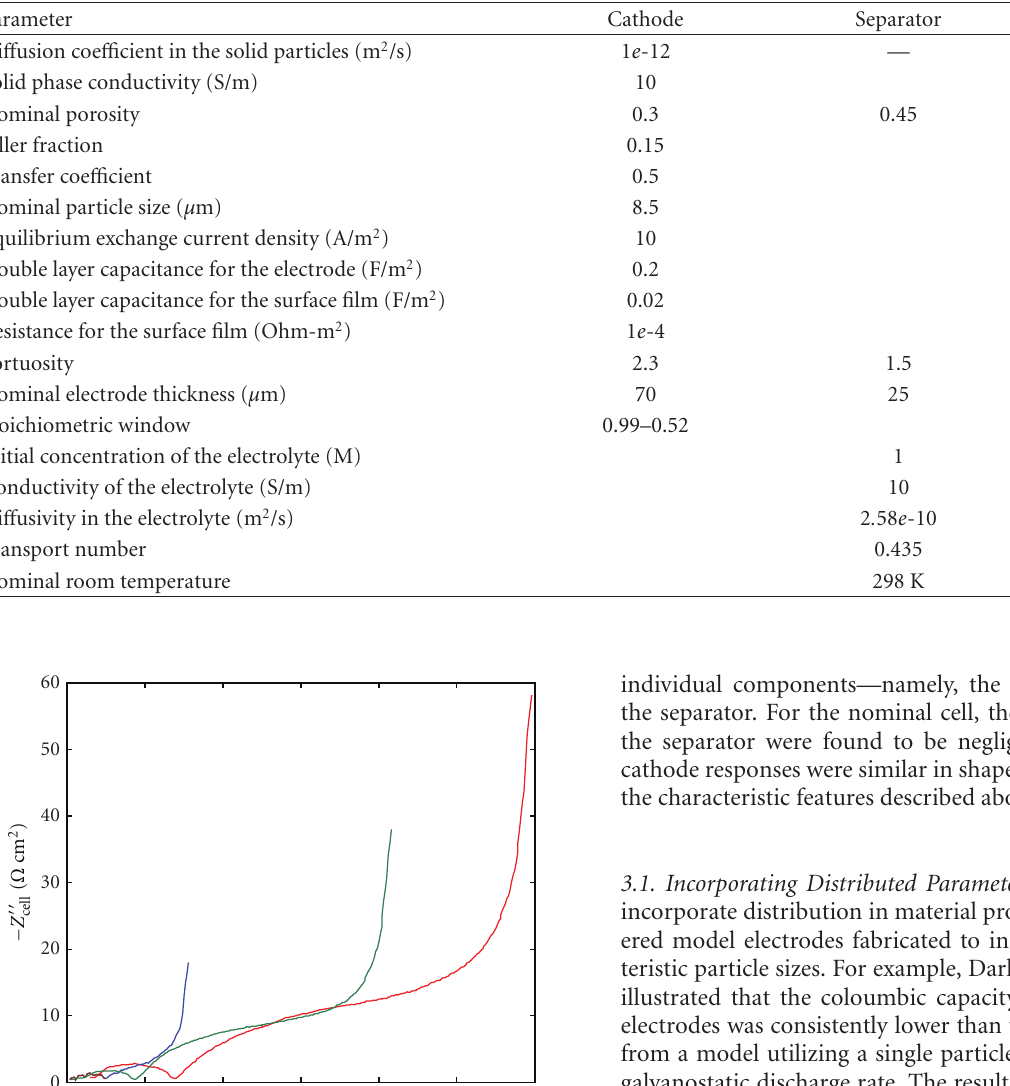
Table 1: List of nominal parameters used in the impedance model.